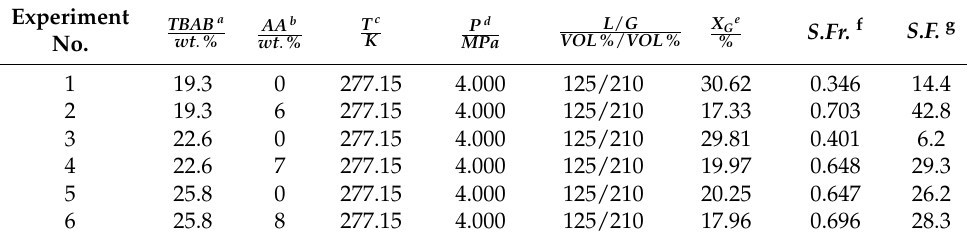
Figure 5. Anti-agglomeration mechanisms of AA.